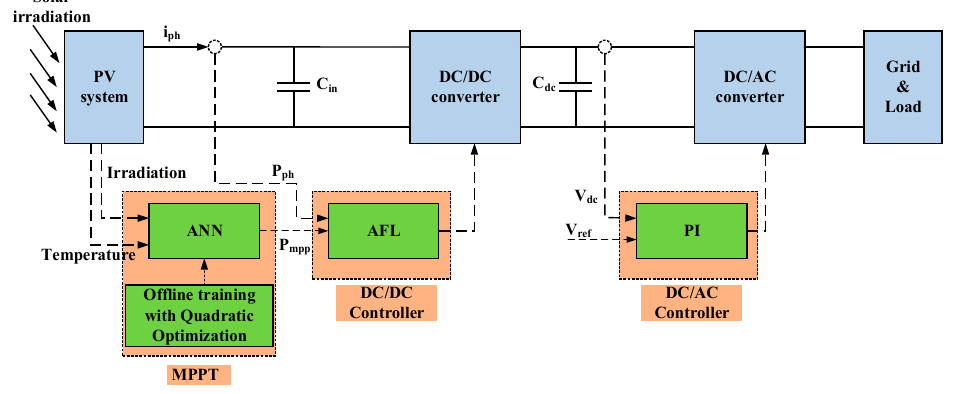
Figure 2. Structure of a PV system with a classical maximum power-point tracking (MPPT)-based artificial neural network (ANN).